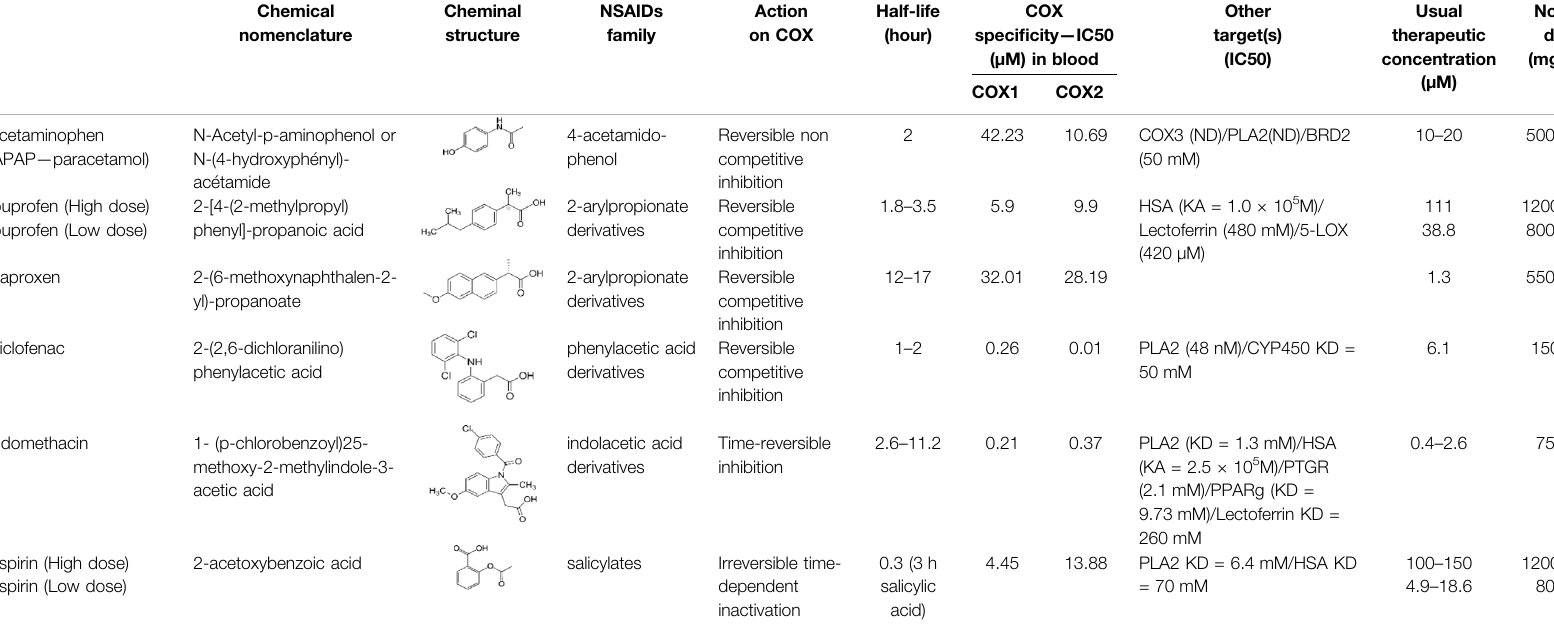
TABLE 1 | Pharmacology of NSAIDs and